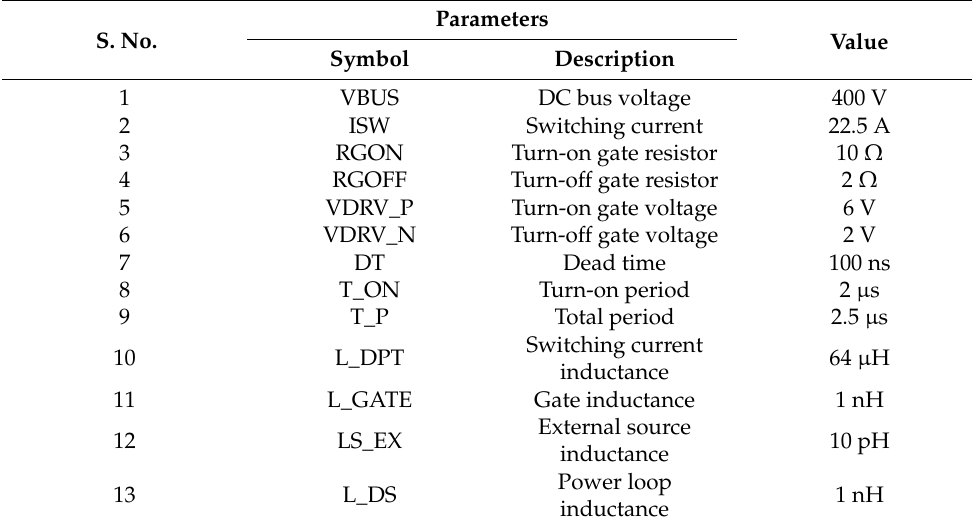
Table 1. Parameters of the double-pulse test (DPT) circuit used for LTSpice simulation. S. No.